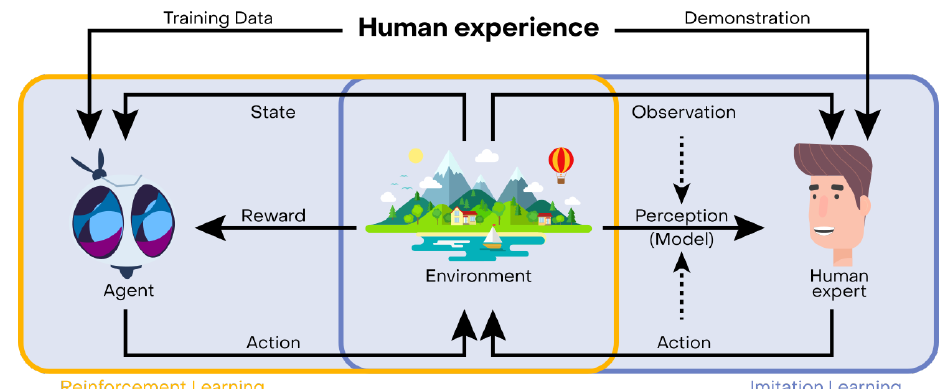
Figure 1. Reinforcement Learning–Imitation Learning (RL-IL) integration structure.